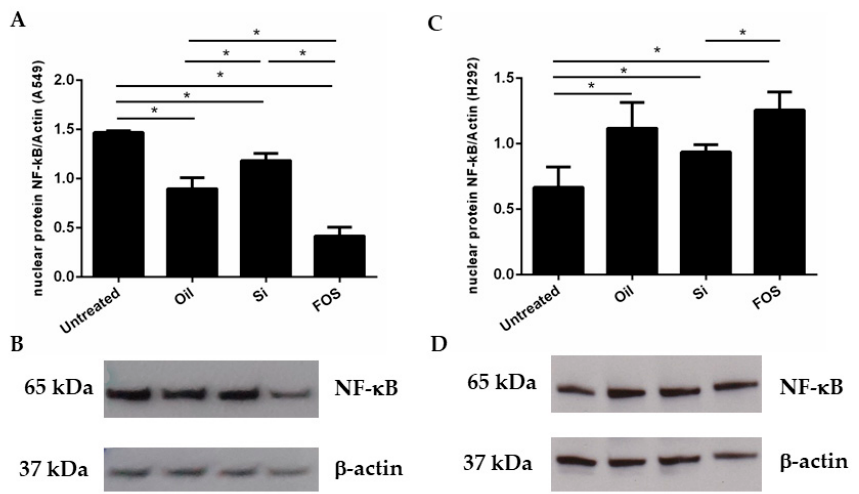
Figure 3. Effects of FOS in NF- κ B expression. A549 and NCI-H292 were cultured with fish oil, silica, and FOS (10 µ g/mL) for 24 h. The nuclear expression of NF- κ B was assessed by Western blot analysis on isolated nuclear protein fractions. ( A – C ) Signals corresponding to NF- κ B on the various Western blots were semi-quantified by densitometric scanning, normalized, and expressed after correction with the density of the band obtained for β -actin. Bars represent the fold change, expressed as the mean ± SE. Graph A shows data on A549, while Graph C shows data on H292. The comparison between different experimental conditions was evaluated by ANOVA corrected with Fisher’s test. * p < 0.05 was accepted as statistically significant. ( B – D ) Representative Western blots were shown for A549 (B) and for H292 (D). Lane 1: untreated; lane 2: oil 10 ug/mL; lane 3: silica 10 ug/mL; lane 4: FOS 10 ug/mL).